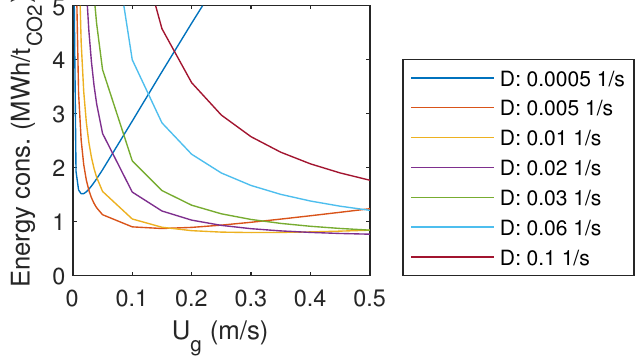
Figure 6. Specific energy